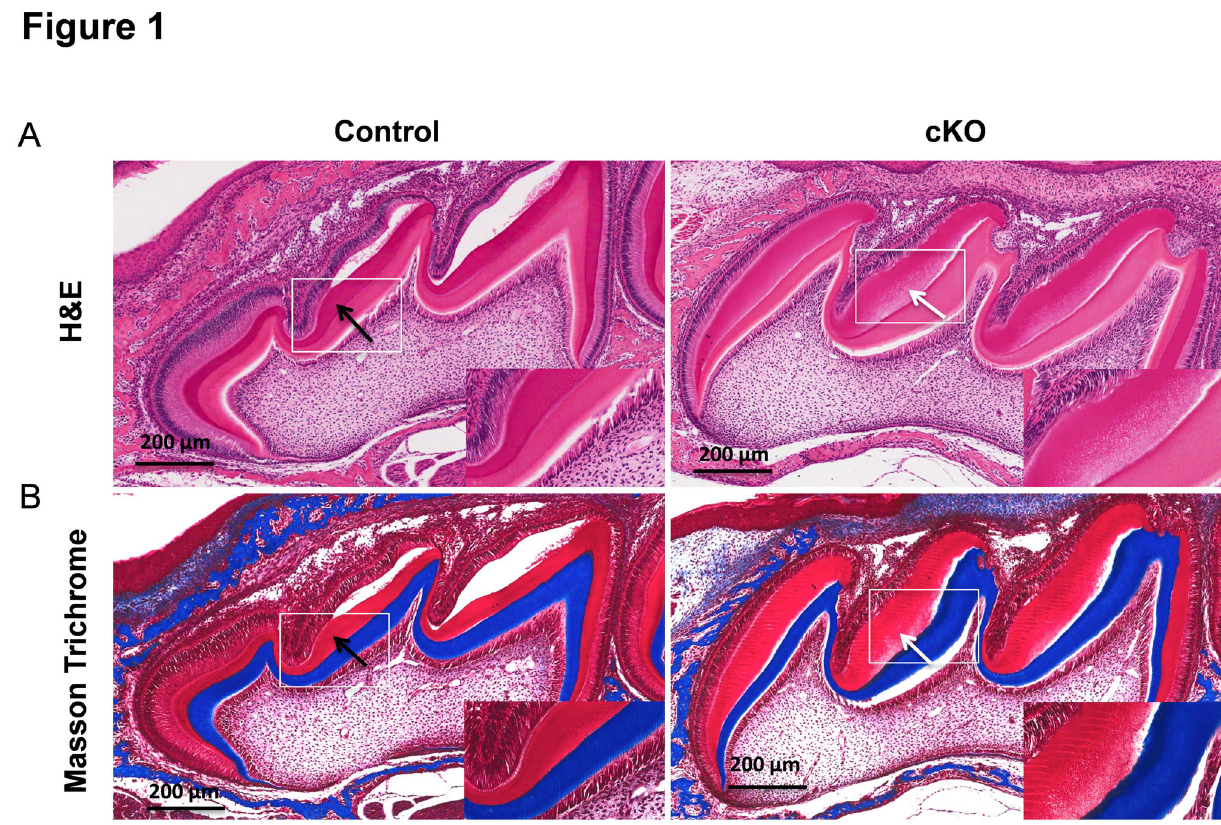
Figure 1. Differential staining pattern of enamel matrix components between control and cKO P7 molars. (A) H&E staining showing dark red staining in enamel matrix in the control molar (black arrow) whereas staining is pale and dispersed within the enamel matrix of the cKO molar (white arrow). (B) Masson Trichrome staining shows similar differential staining pattern in the enamel matrix between the two groups. Bar = 200 µm. Higher magnifications are shown in insets. doi: